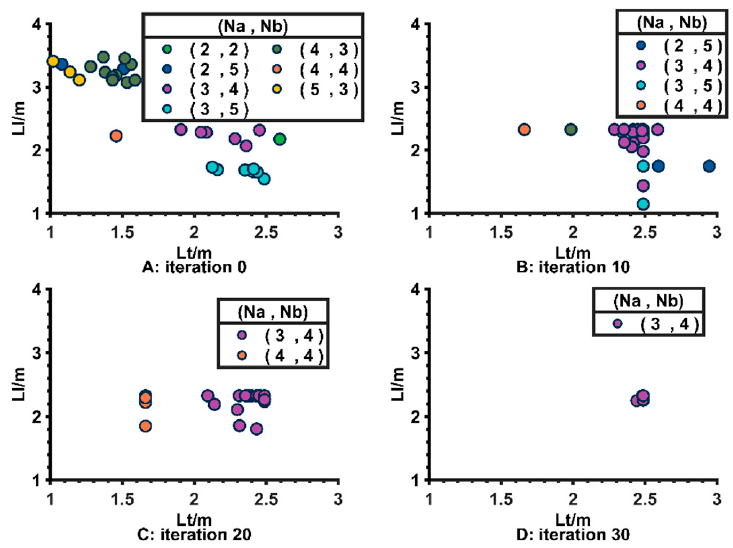
Figure 6. ( A – D ) Swarm ( N a , N b , L t , L l ) movement toward an optimal solution with iterations in the IPSO.